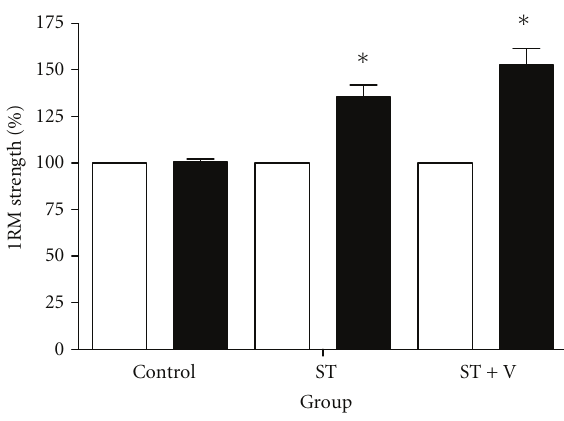
Figure 1: Mean ± SE 1RM strength (expressed as a percentage change) for all groups before (light bars) and after training (dark bars). ∗ denotes an increase in strength following training ( P < 0 . 016). There were no di ff erences in strength between the ST and ST + V groups following training ( P = 0 .